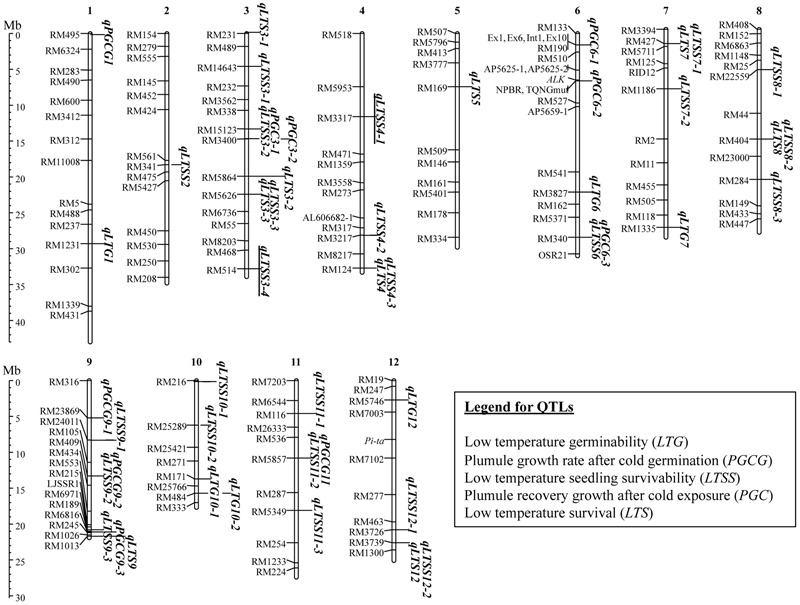
Quantitative trait loci (QTL) locations based on genome wide association study (GWAS) mapping analysis using the rice mini-core collection (RMC) as reported in Table 3. The QTL, qLTSS3-4 and qLTSS4-1 (underlined) are novel, whereas the other QTL overlap with or are within 1.5 Mb of previously published chilling tolerance QTL (Supplementary Table S2). Details of the individual QTL are in Table 3. Markers are further described in Bryant et al. (2011), and the figure was created in MapChart (Voorrips, 2002).